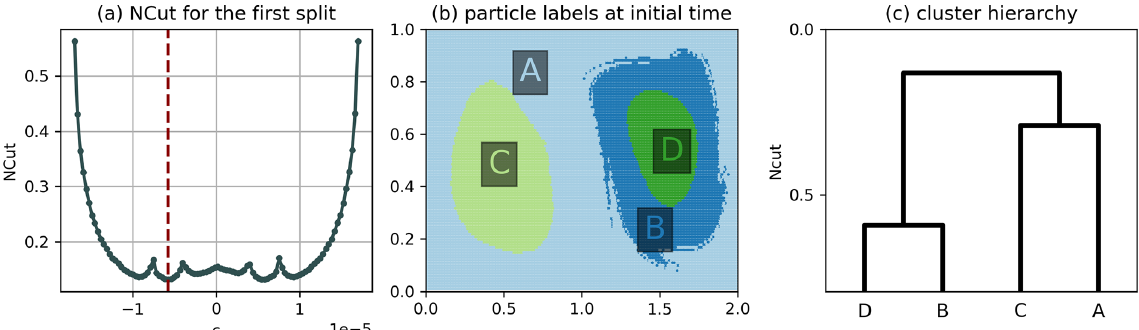
Figure B5. Hierarchical clustering result of the double gyre using algorithm 2 of Sect. 3.3 and (cid:49)x = (cid:49)y = 0 . 04. (a) NCut for the first split as a function of the cutoff c , where c = 0 corresponds to a cut along the transport boundary, the red line indicating the minimum found by our algorithm. (b) Result of the hierarchical clustering. (c) Dendrogram representing the hierarchy, where the horizontal lines correspond to the NCut value after each split. There is no global or local minimum at c = 0 in (a) , which is why the transport boundary is not detected. Instead, two global minima are present in (a) , but our implementation selects the left minimum for the first split due to the choice of sampling